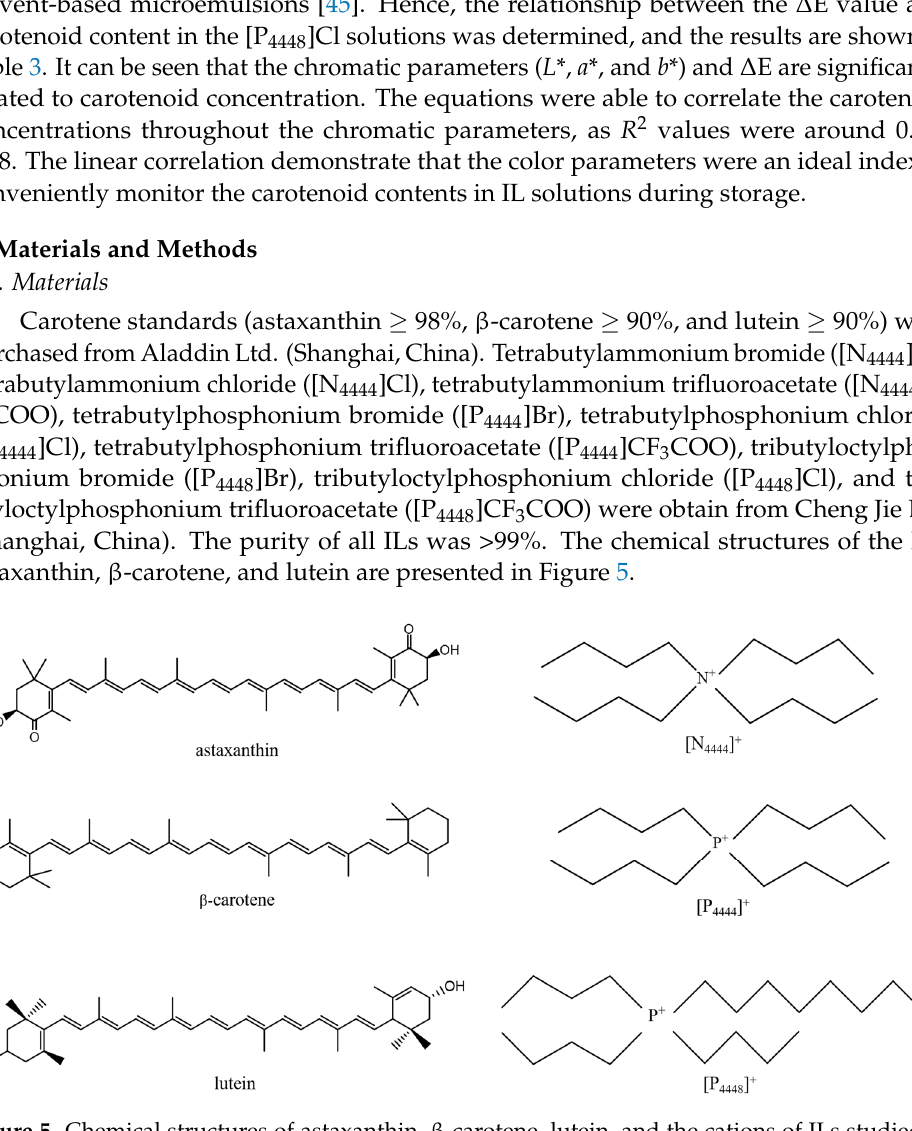
Figure 5. Chemical structures of astaxanthin, β -carotene, lutein, and the cations of ILs studied in this